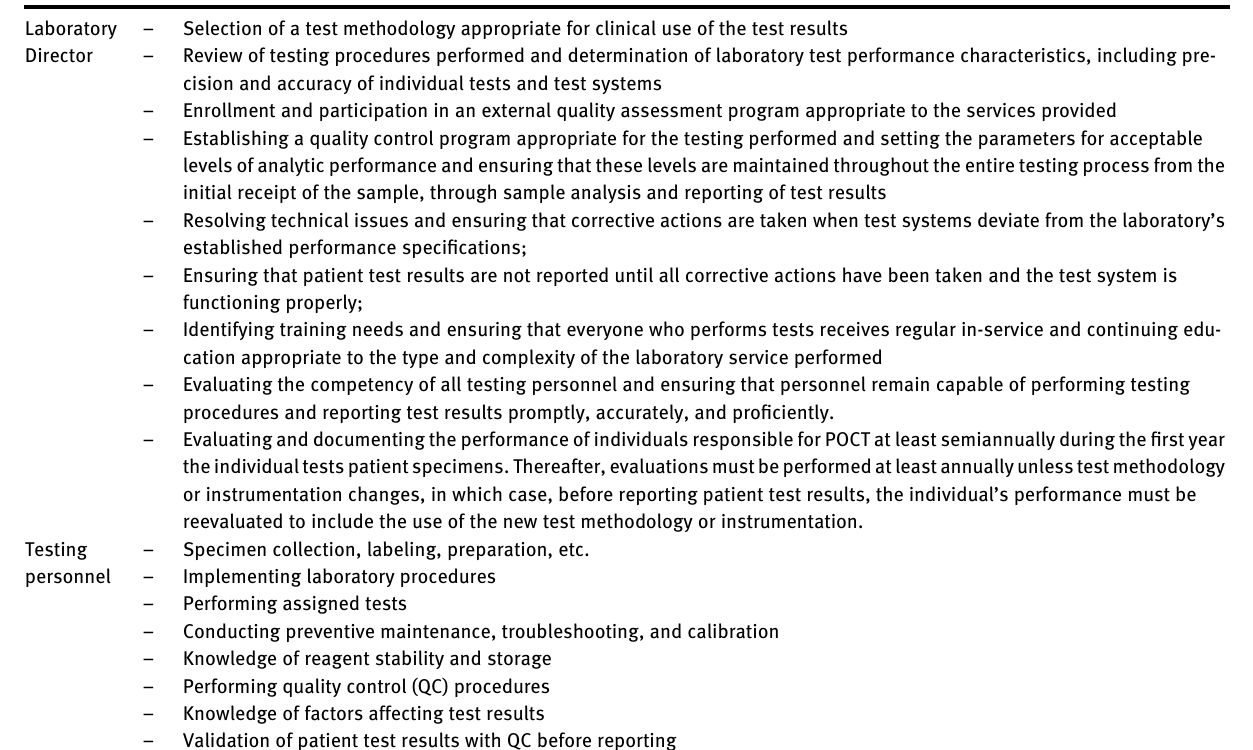
Table  : Summary of key responsibilities of a laboratory director and testing